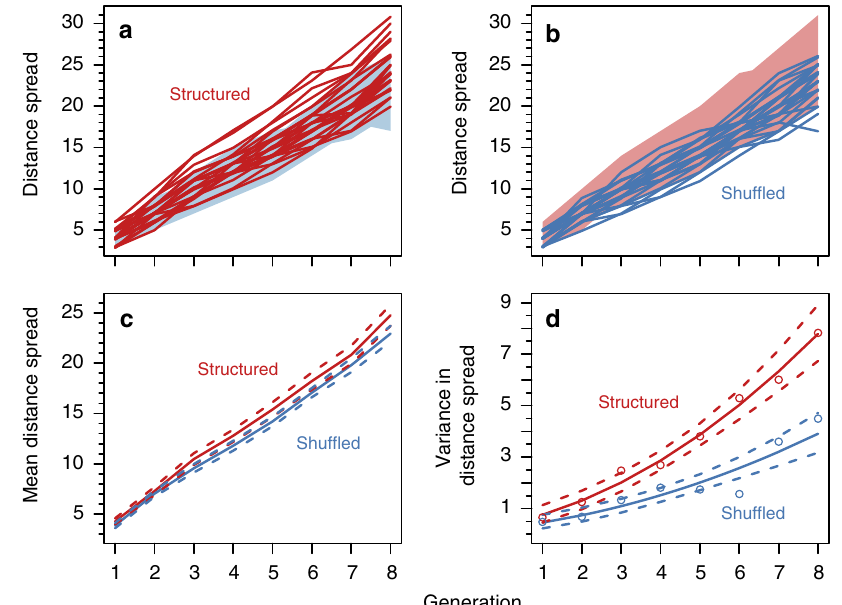
Figure 1 | Speed and variability of structured and shuffled range expansions. Experimental results of range expansions with structured ( n ¼ 28) and shuffled ( n ¼ 29) populations initiated from a single well-mixed source population. ( a , b ) Distances spread in each treatment. The lines show data for individual replicates whereas the shaded regions show the observed range of distance spread in the other treatment for reference. ( c ) Mean distance spread through time for each treatment (solid lines) and sample estimated 95% confidence intervals (dashed lines). ( d ) Model-estimated variances for each treatment with 95% confidence intervals. The observed variances for each treatment are shown as points. In all panels the structured treatment is shown in red and the shuffled treatment in blue. Spatial evolution resulted in a higher mean expansion speed (parametric bootstrap, treatment by generation interaction: P ¼ 0.0137) and higher variance in expansion speeds (likelihood ratio test, treatment by generation interaction: P ¼ 1.93 (cid:2) 10 (cid:3) 5